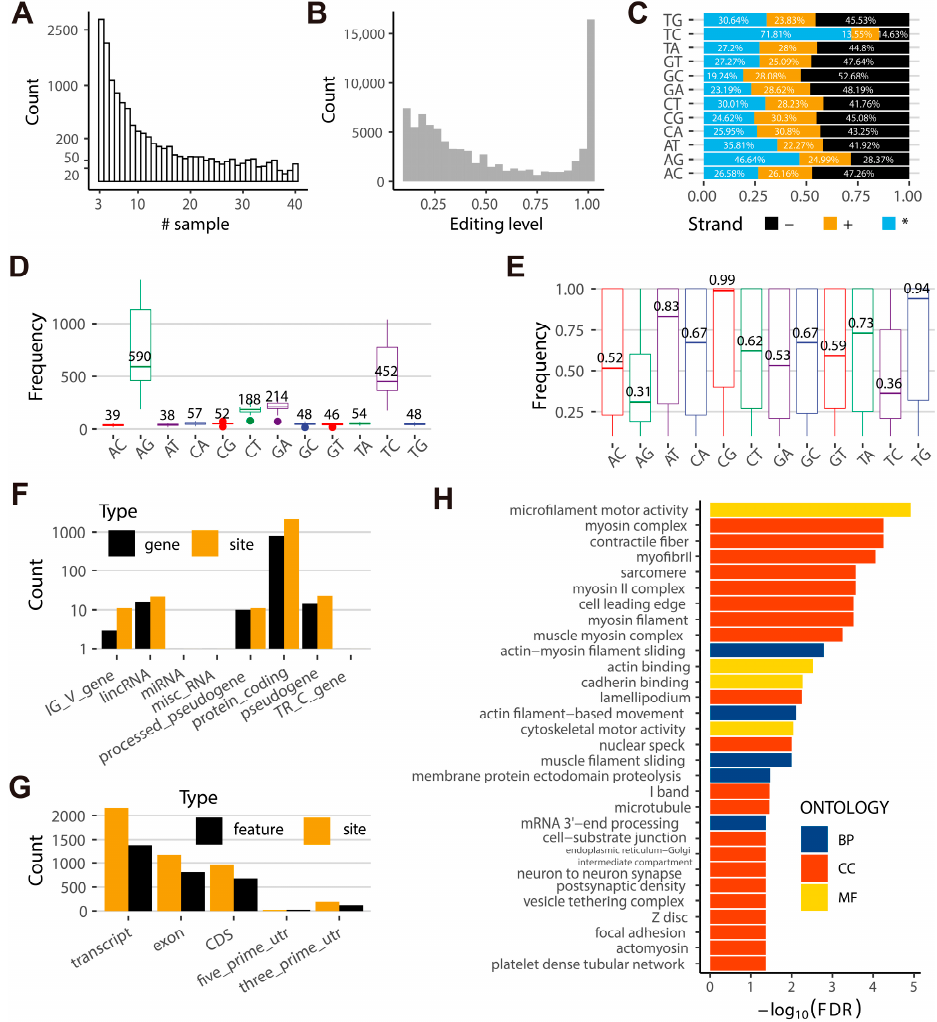
Figure 2. Gene annotation and enrichment analysis of A-to-I and C-to-U editing. ( A ) The count of RESs across goat individuals. ( B ) The editing levels of RESs. ( C ) The proportion of 12 RNA editing types in the DNA double-strand, +: DNA positive strand, − : DNA reverse strand, *: ambiguous strand. ( D ) The median count of RESs across RNA editing types. ( E ) The editing levels of RESs across RNA editing types. ( F ) Gene biotype of A-to-I and C-to-U editing sites and genes. ( G ) The position of A-to-I and C-to-U editing sites in different regions of a gene. ( H ) GO enrichment of A-to-I and C-to-U editing-related protein-coding genes. BP: Biological process, MF: Molecular function, CC: cellular component.